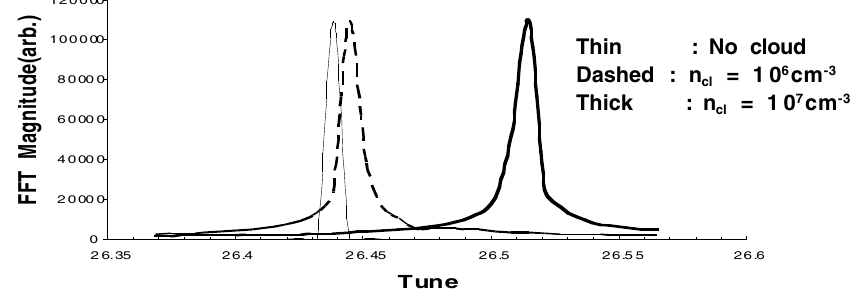
FIG. 8. Vertical tune for different cloud densities.